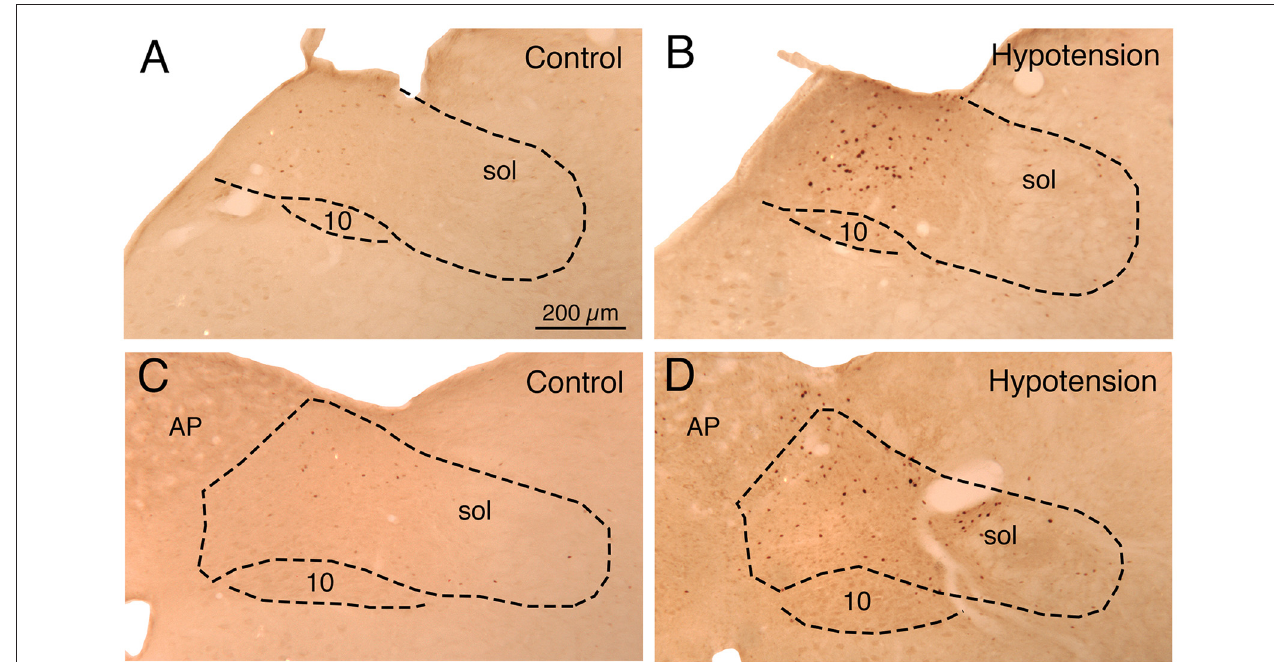
FIGURE 1 | Images showing the distribution of c-fos immunolabeling in: (1) nucleus of the solitary tract (NTS) just anterior to the area postrema (AP) in a sham hypotension rat (A) and a hypotensive rat (B); and (2) NTS at the level of AP in a sham hypotension rat (C) and a hypotensive rat (D). The NTS is outlined, as is the vagal motor nucleus (10), and the location of the solitary tract (sol) is indicated. Note that hypotension induces c-fos in any neurons around and medial to the solitary tract. All images are at the same magnification.